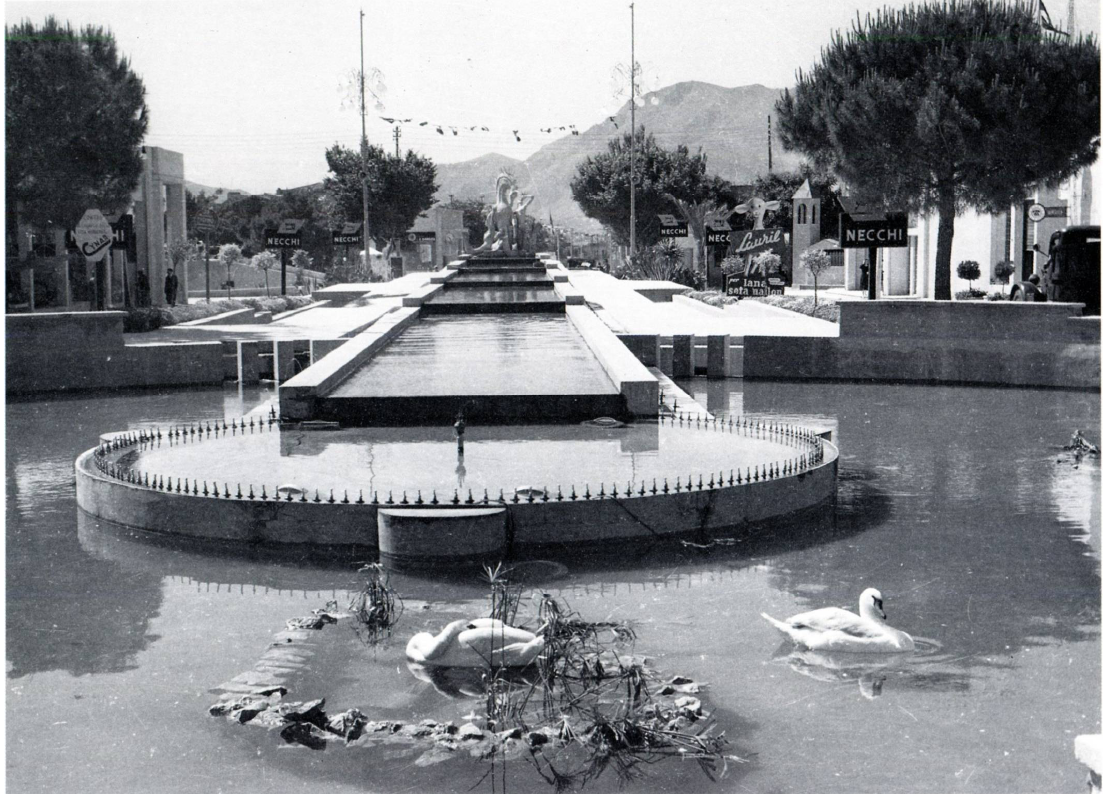
Figure 8. The monumental fountain in Piazzale delle Sirene,